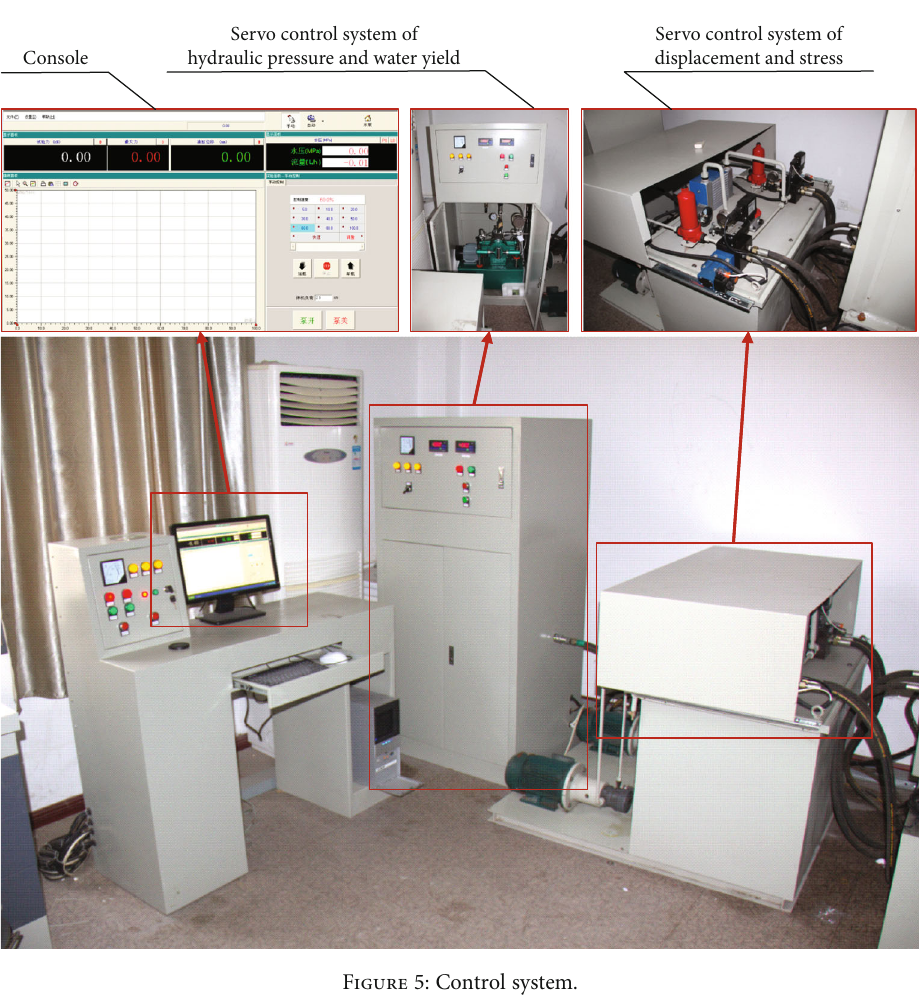
Figure 5: Control system.